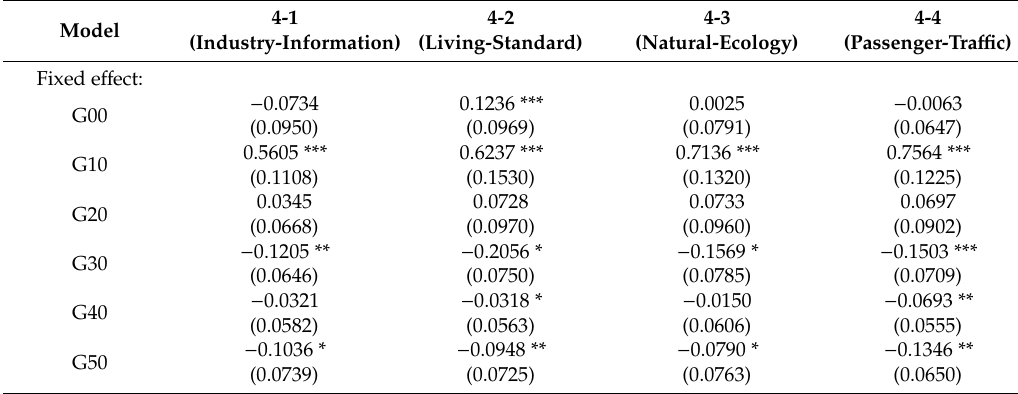
Table 6. The estimation of parameters and variance components (with standard errors) for Model